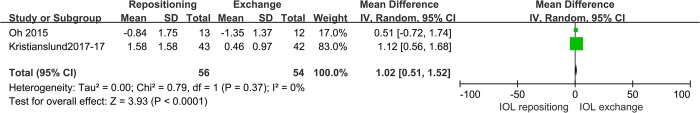
Comparison of IOL repositioning and IOL exchange in terms of postoperative SE.